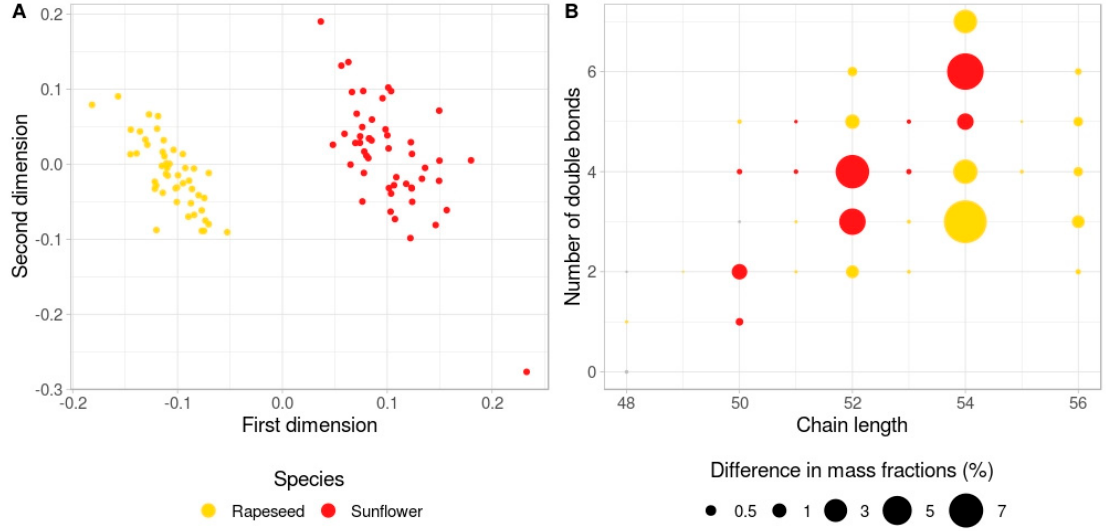
Figure 2. Triglyceride comparison between sunflower and rapeseed. ( A ) Multidimension scaling plot (one minus Spearman correlation coefficient was used as the distance, two dimensions) of samples demonstrating a clear segregation of rapeseed and sunflower samples. ( B ) The difference in the TAG mass fractions between rapeseed and sunflower. Color indicates which species possess a higher amount of a certain TAG. Circle size represents the absolute difference in mass fractions. Grey circles correspond to the TAGs that do not show statistically significant differences.